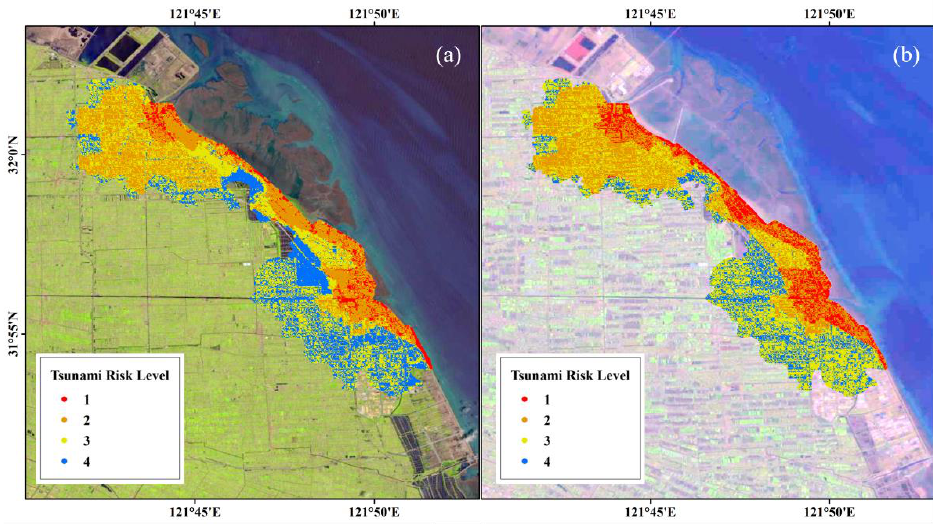
Figure 7. ( a ) Tsunami risk levels for 2013. ( b ) Tsunami risk levels for 2022.